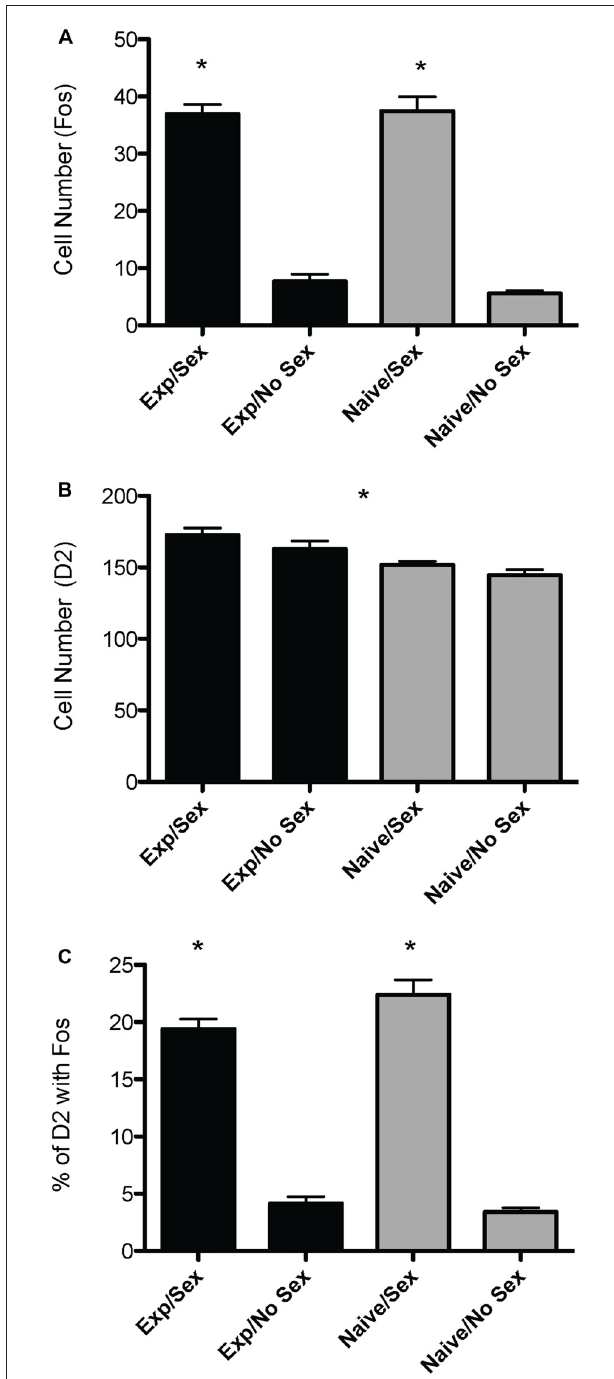
FIGURE 2 | Effects of sexual activity and sexual experience on D2- and Fos-immunoreactivity in the mPOA of male rats. (A) Animals who copulated prior to sacrifice had significantly more Fos-positive cells. (B) Animals with sexual experience had significantly more D2-immunopositive cells compared to naïve animals. (C) There was an interaction between sex and experience on the percentage of D2 cells that contained Fos; specifically, naïve animals copulating for the first time had a significantly higher percent of D2 cells that expressed Fos. ( ∗ p < 0.05).